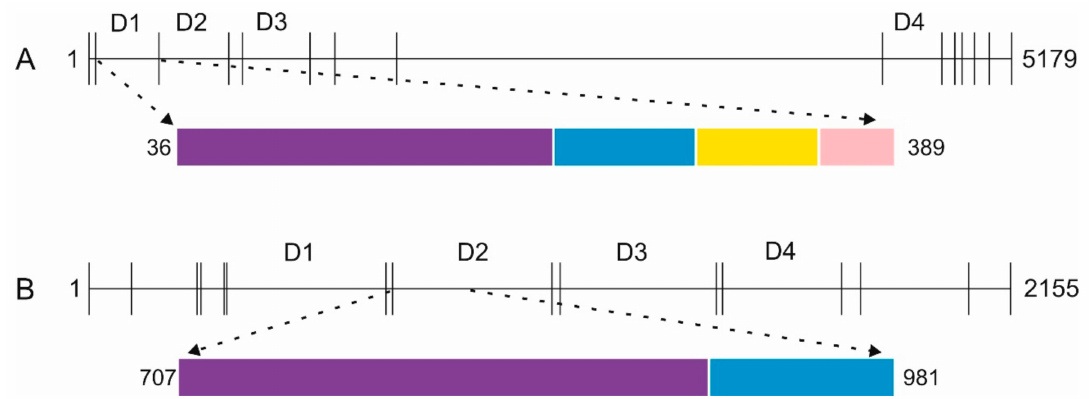
Figure 1. Schematic of the domain organization of mucin 2 and alpha tectorin. ( A ) Human mucin 2, ( B ) human alpha tectorin. Both are large multi-domain proteins. Amino acid numbering for the proteins and the domain constructs are shown. Di ff erent domains are colored separately: von Willebrand Factor D(VWF-D)domain(purple), C-8region(blue), TILdomain(yellow), E-8region(pink). TheD-assemblies are represented by “D” [23]. Vertical lines donate domain boundaries. For clarity other domain types are not